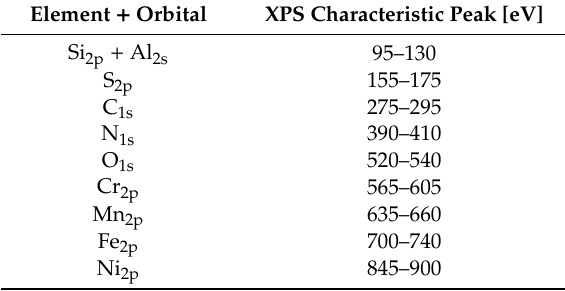
Table 3. Location of the XPS characteristic peaks for the most relevant elements for the studied